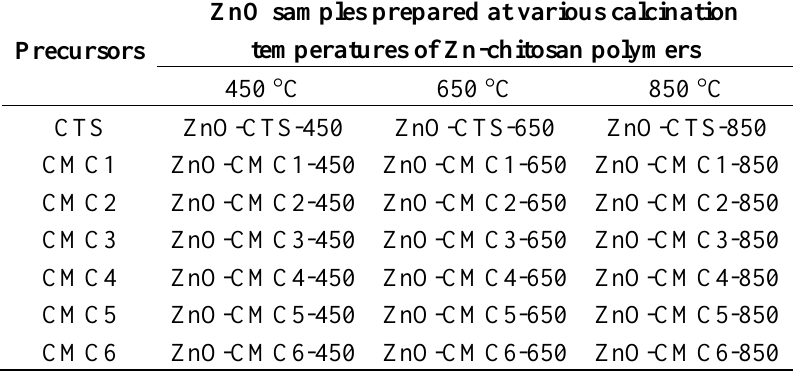
Table 1. ZnO prepared from various